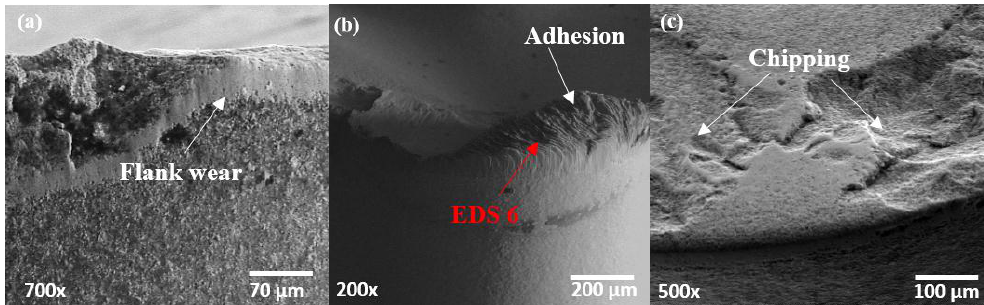
Figure 9. SEM images of uncoated insert after machining SDSS. ( a ) Flank face after etching; ( b ) cutting tool before etching; and; ( c ) cutting tool with chipping.